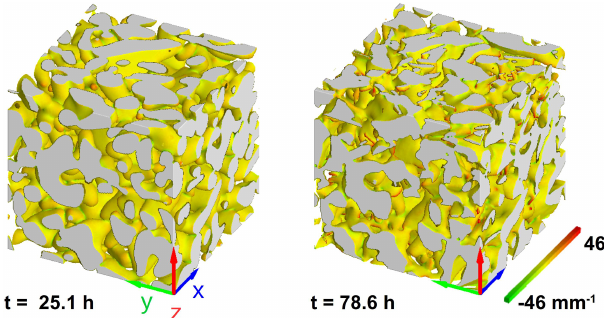
Figure 4. Time evolution of the microstructure in a cube of 2.34mm edge length cropped out of the centre of the specimen. The inter- faces are coloured based on the local mean